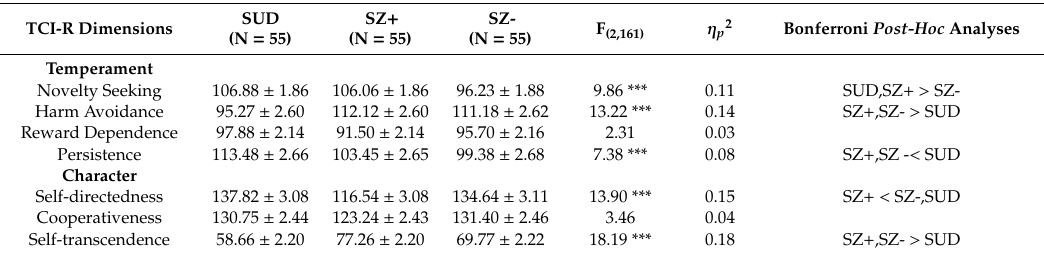
Table 3. Results for the Temperament and Character Inventory-Revised (TCI-R) dimensions for the three groups. Mean, standard error, and MANCOVA results.